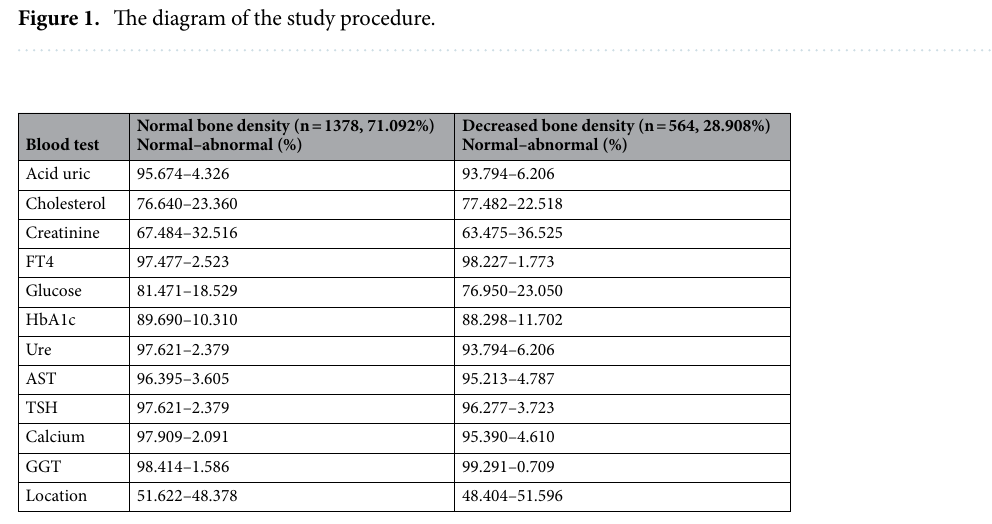
Table 3. The statistical distribution of the data in the second scenario.